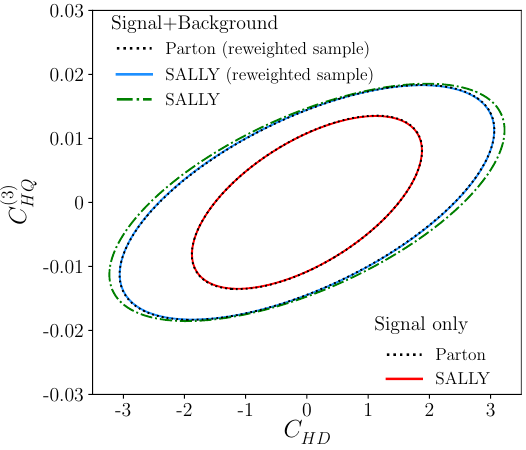
Figure 10 . A comparison of the 95% CL limits based on the Fisher information in the two- parameter space for a simpli(cid:12)ed version of our process, comparing the Fisher information obtained from a set of parton level event weights (dotted lines), using a Sally estimator trained on the same sample events (solid lines), and using a Sally estimator trained on separate signal and background event samples (dot-dashed line). The inner ellipses show the results when evaluated only on the signal sample, while the outer ellipses show the results taking into account both signal and